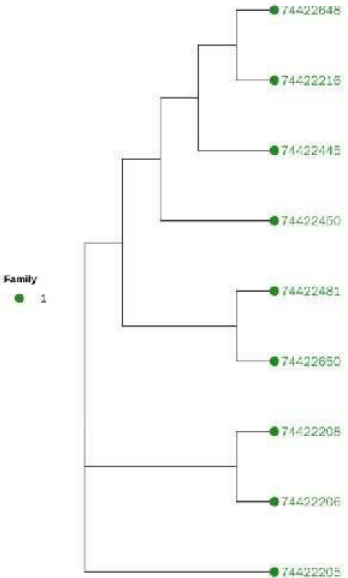
Figure 9. Cluster analysis results of bull samples. Note: one color represone family.